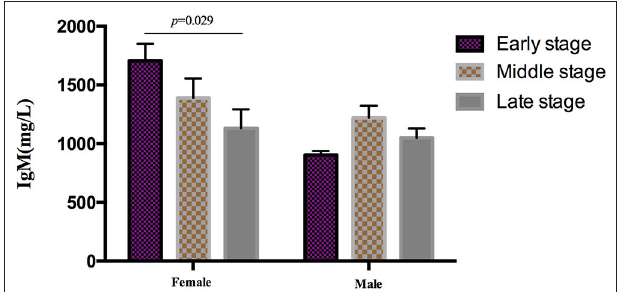
FIGURE 1 | Differential expression of IgM in different clinical stages MSA patients according to sex. IgM levels gradually decreased from early to later stages exclusively in female ( p = 0.029), no significant difference was found in male